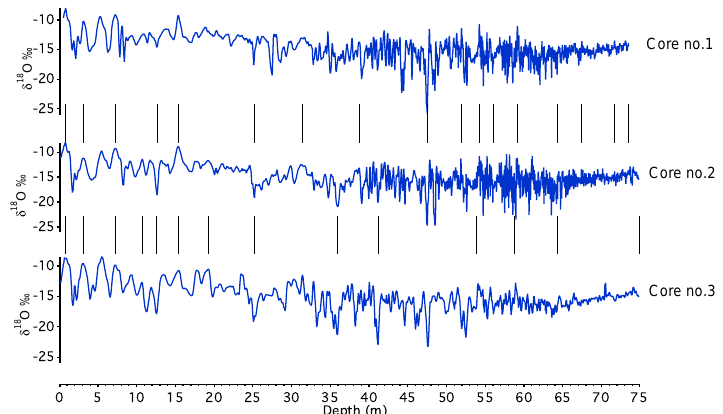
Figure 10. Alignment of the stable isotopic profiles from Mt. Ortles cores no. 1, no. 2 and no. 3 by depth. Vertical bars indicate the points used to tie cores no. 1 and no. 3 to core no. 2. The latter is used as the